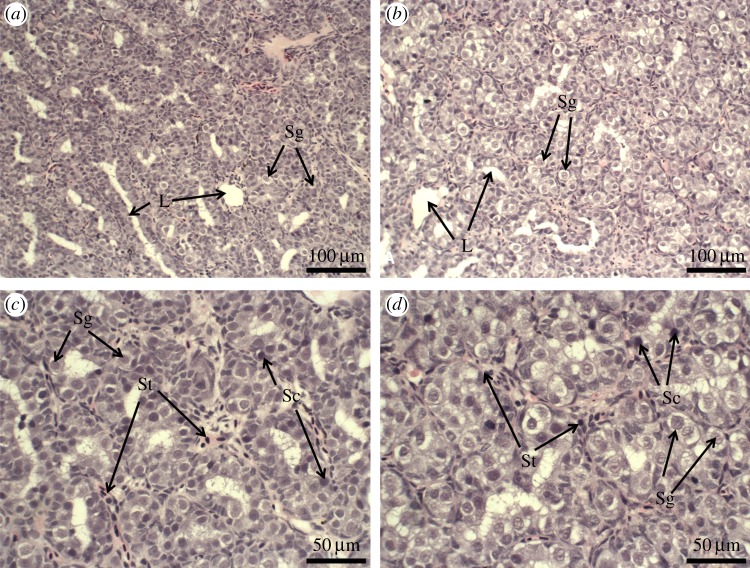
Histological sections of 2-year-old male triploid (n = 7) and diploid (n = 6) Atlantic salmon. (a,c) Diploid males showing developed gonadal structures (L, lumen) and spermatogenesis in gonads, including the presence of spermatogonia (Sg), spermatids (St) and spermatocytes (Sc). (b,d) Triploid male salmon showing similar gonadal structures to diploid salmon, including definitive aspects of spermatogenesis.